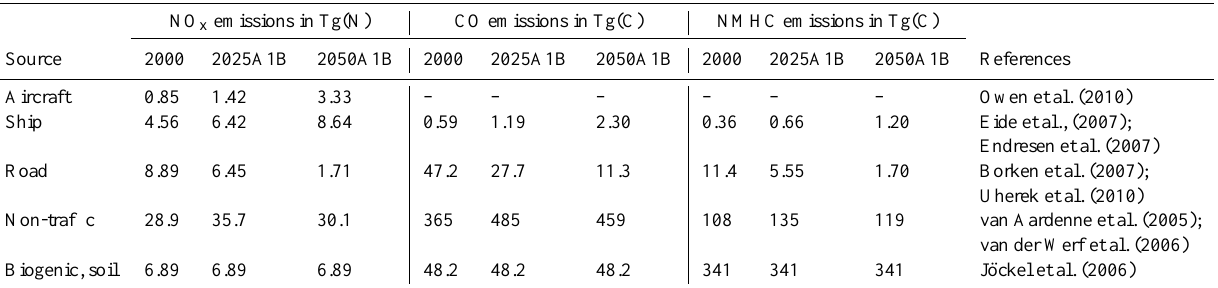
Table 1. Global annual emissions of NO x , CO and NMHC provided by QUANTIFY (http://www.ip-quantify.eu) for the years 2000, 2025 and 2050 in the A1B scenario. The 2000 emissions are from the final QUANTIFY dataset and thereby differ from the preliminary emissions used in Hoor et al.